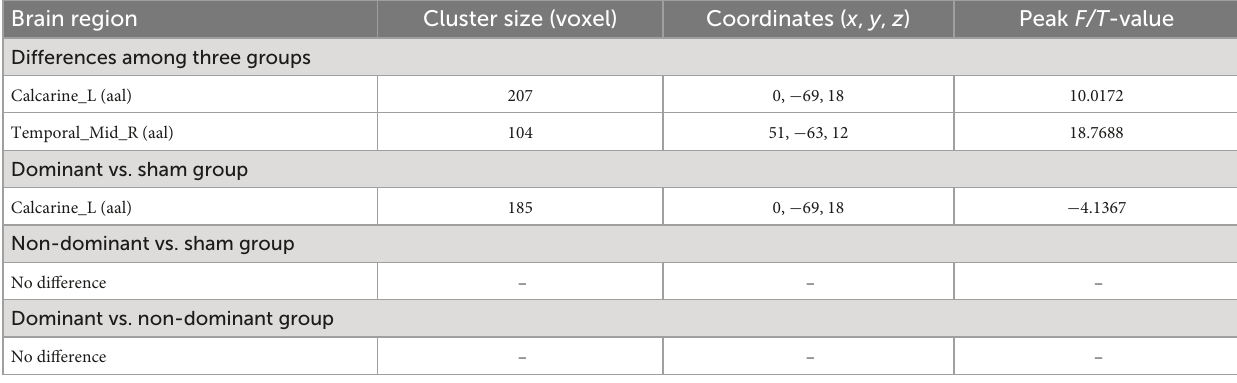
TABLE 3 Brain regions with fALFF differences after iTBS in dominant cerebellum group, non-dominant cerebellum group, and sham